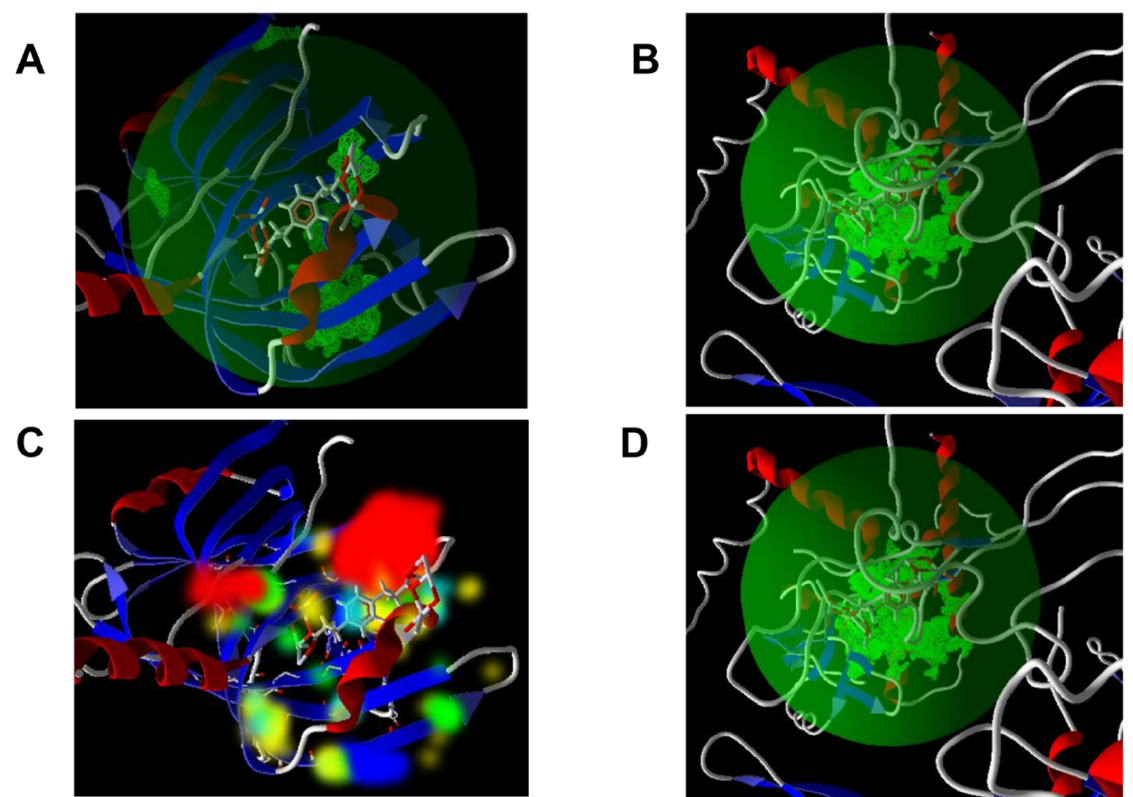
Figure 10. The potential ligand binding cavity of ( A ) E. coli and ( B ) S. aureus with flexible residues. Energy map of the ligand at the binding cavity of the ( C ) E. coli and ( D ) S. aureus proteins. Reproduced with permission from [129].